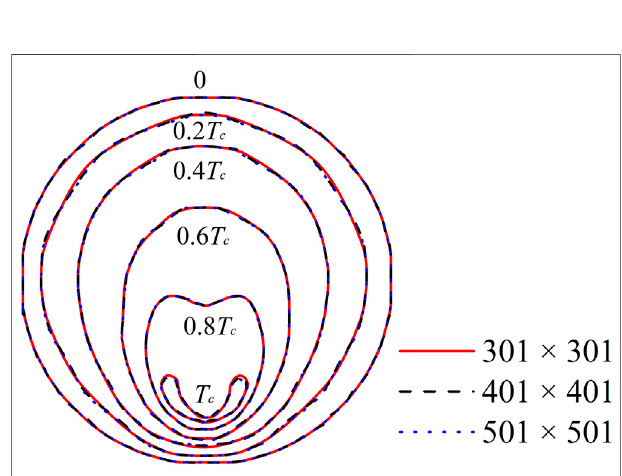
FIGURE 6 | Validation of grid independent ( λ =